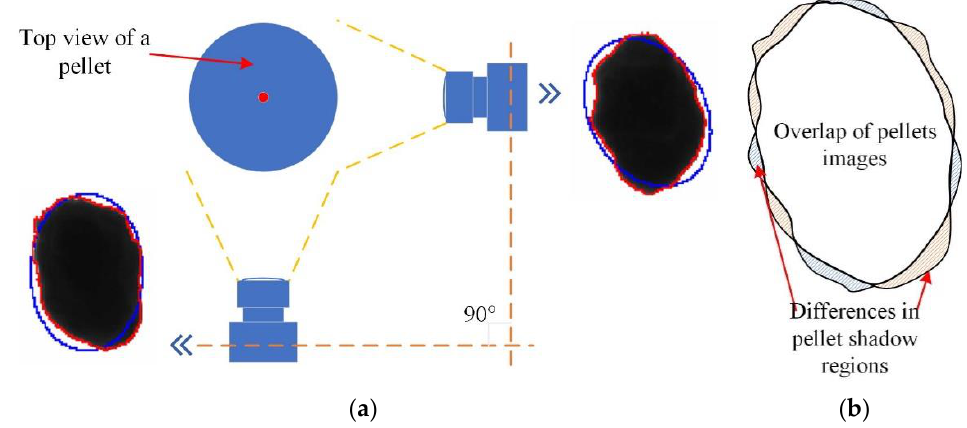
Figure 6. ( a ) The pellet is scanned using a 90° angle between the camera’s field of view and the longitudinal axis of the pellet, when we receive the largest area limited by the pellet and image rotated by 90°; ( b ) evaluation of discrepancy of pellet overlapping area according to averages of areas. Results received from analysis of monoammonium phosphate pellets indicate that discrepancy of shape of pellets increases with increasing size of a pellet. However, ≤ 95% of all pellets of the material with which we are working are distributed in the interval from 0.2 mm to 1.0 mm. Within these boundaries, roundness of pellets according to ration of diagonals is distributed within boundaries from 0.4 to 0.8. The discrepancy among areas limited by di ff erent contours produced according to longitudinal axis that is in the mentioned intervals is < 3%. Because of the contamination of equipment, pellets tend to become smaller during production and it is su ffi cient to evaluate their shape from one